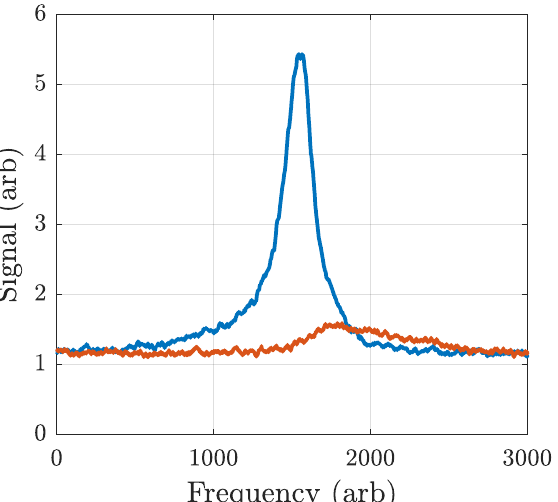
Figure 6. Detected fluorescence with cooling lasers for the 2D-MOT on (blue trace) and off (red